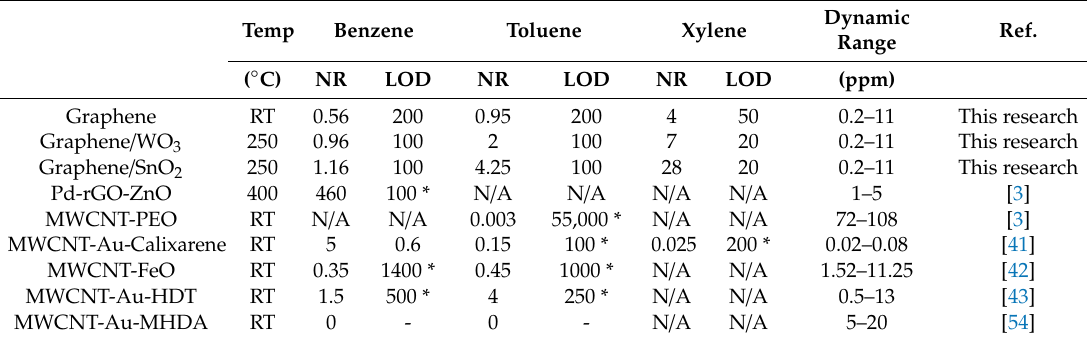
Table 2. Comparison of the normalized responses (NR) expressed as response % × ppm − 1 (where response % is defined as Rg / R 0 (%)) for benzene, toluene, and xylene for di ff erent carbon nanomaterial gas sensors. Other parameters such as the limit of detection (LOD) expressed in ppb, operating temperature ( ◦ C), and dynamic range of concentration measured experimentally (in ppm) are given too.